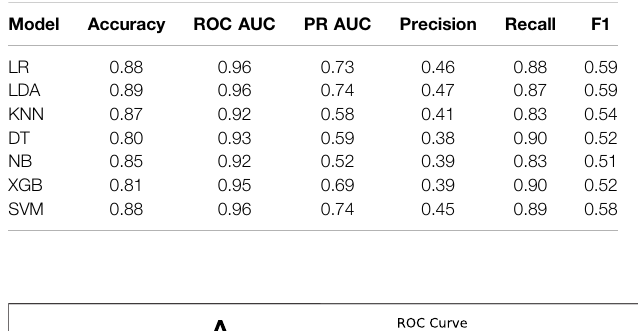
TABLE 3 | Experiment 2 TrainingModels performance.